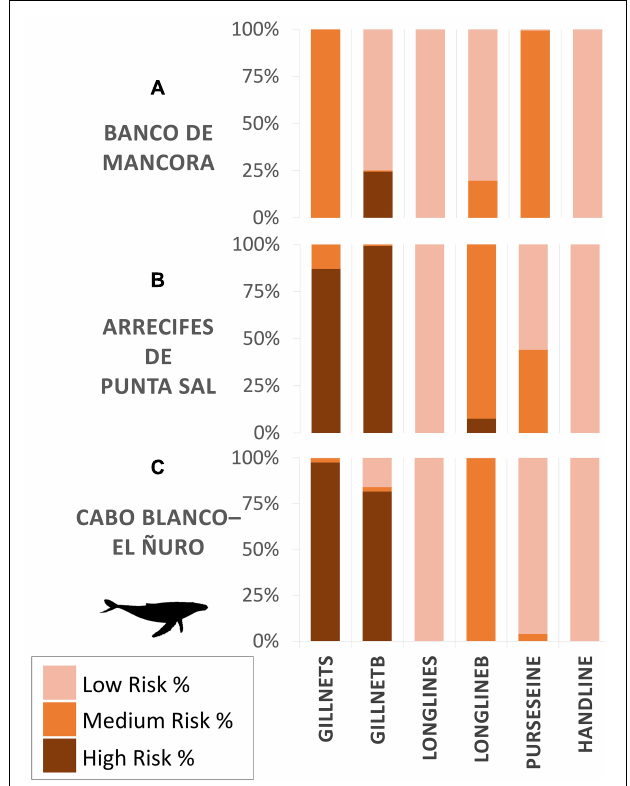
FIGURE 5 | Bycatch risk percentages calculated for humpback whales for each gear type. Subzones assessed are composed of proposed marine protected areas: (A) Banco de Mancora, (B) Arrecifes de Punta Sal, and (C) Cabo Blanco–El Ñuro, as part of the Grau Tropical Marine